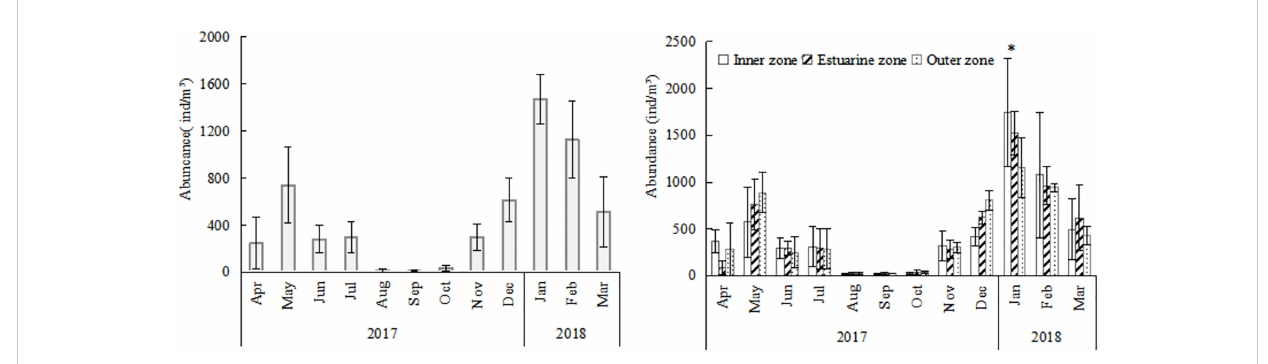
FIGURE 3 Annual variation and annual spatial variations of Oithona similis in Jiaozhou Bay, vertical bars represent deviation (SD). * means signi fi cantly difference